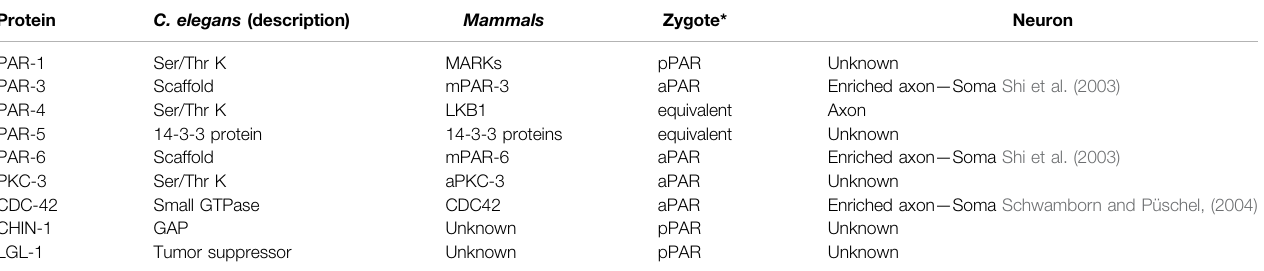
TABLE 1 | Par genes and PAR proteins in C. elegans and mammals.